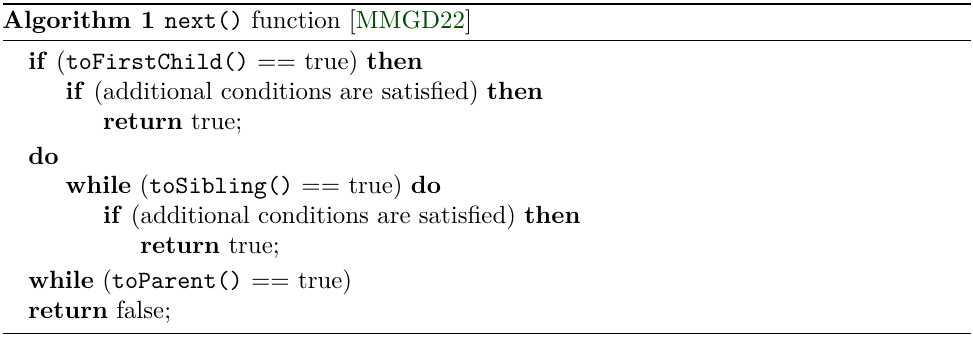
Algorithm 1 next() function